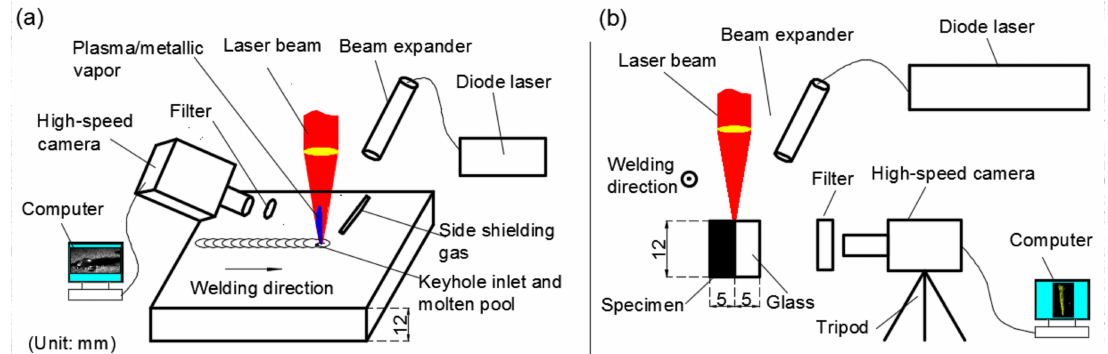
Figure 2. Schematic of the laser welding setup for: ( a ) bead-on-plate welding, and ( b ) welding with modified ‘sandwich’